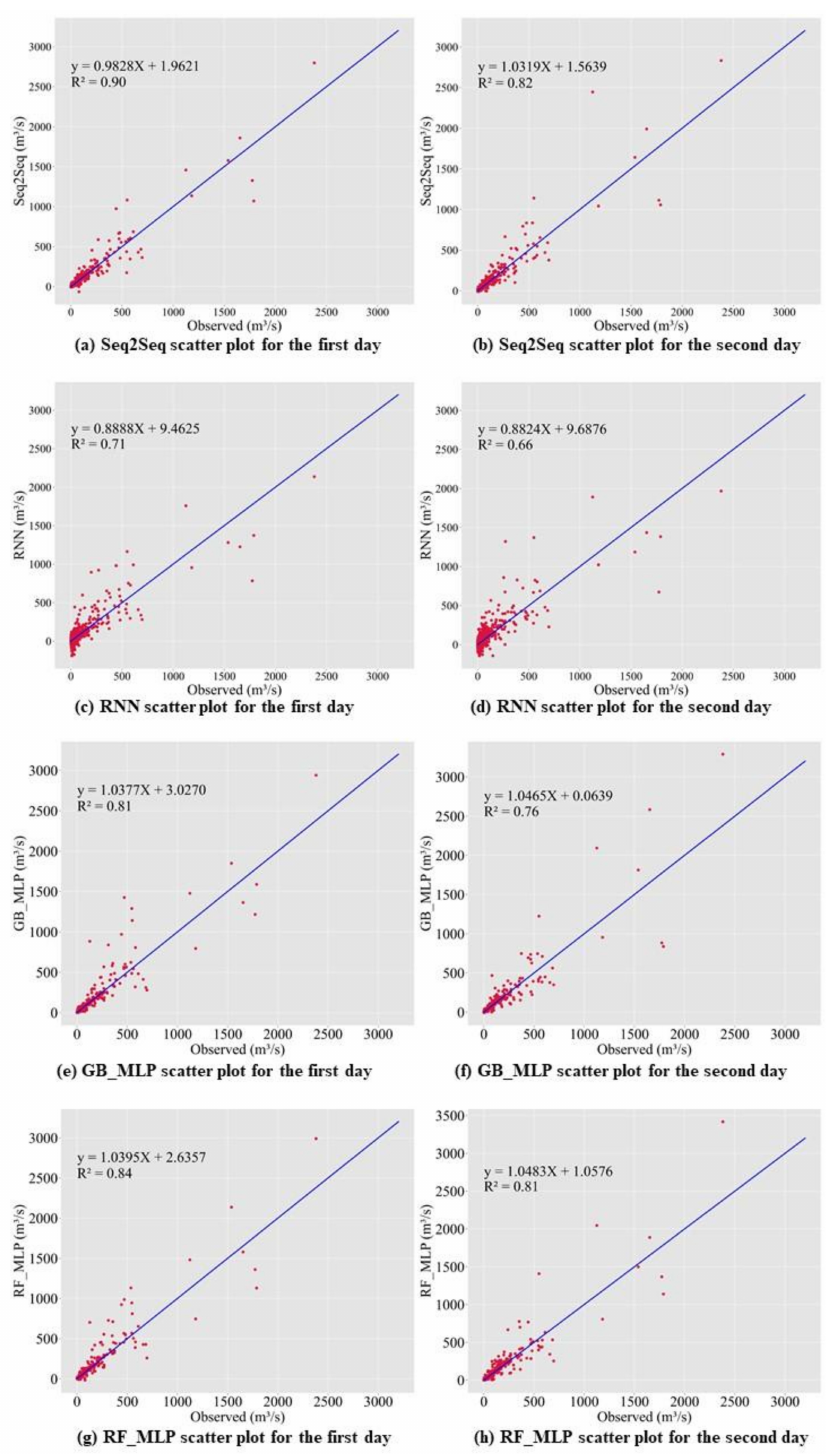
Figure 11. Scatter plots for predicting inflow rate with the proposed model and based